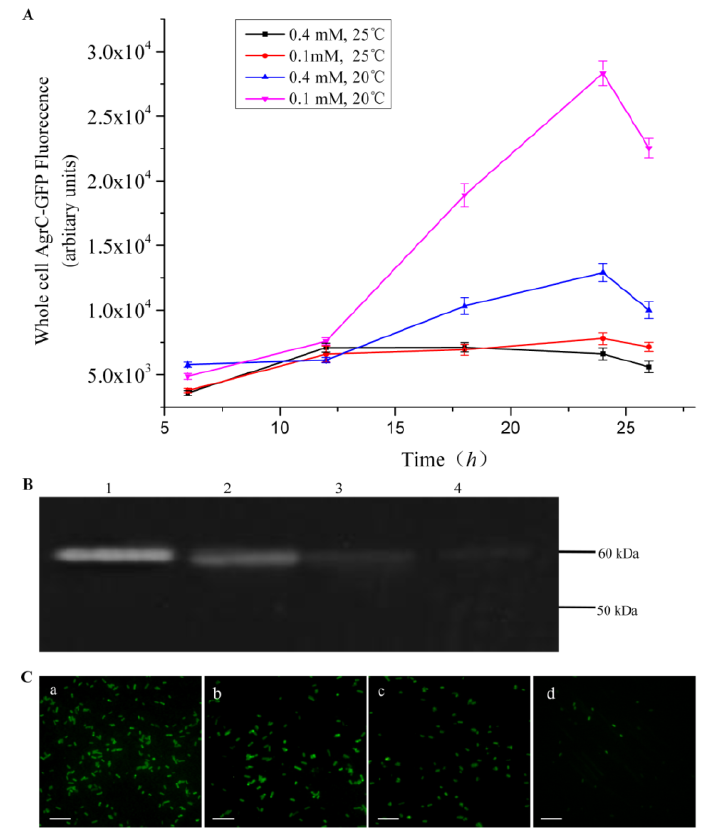
Figure 2. Screening of AgrC-GFP expression under different temperatures and inducer concentrations. ( A ) Monitoring of whole-cell fluorescence intensity from cells overexpressing AgrC-GFP every 6 h after IPTG induction. Black, red, green, and blue lines represent four induction conditions, including 0.4 mM IPTG at 25  C; 0.1 mM IPTG at 25  C; 0.4 mM IPTG at 20  C; and 0.1 mM IPTG at 20  C. The experiments were performed in triplicate; ( B ) In-gel fluorescence detection for AgrC-GFP expression. The lanes were loaded as follows: (1) 0.1 mM IPTG, 20  C; (2) 0.4 mM IPTG, 20  C; (3) 0.1 mM IPTG, 25  C; and (4) 0.4 mM IPTG, 25  C; ( C ) Fluorescence microscopy images of cells expressing AgrC-GFP. E. coli C43 cells were induced under different conditions as indicated above the panel; (a) 0.1 mM IPTG, 20  C; (b) 0.4 mM IPTG, 20  C; (c) 0.1 mM IPTG, 25  C; and (d) 0.4 mM IPTG, 25  C. The scale bar is 10 μ m. For each sample, an approximately equal number of cells were